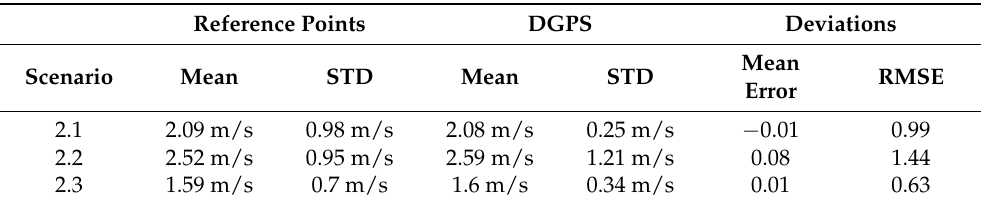
Table 6. Comparison of forward speed between Reference Points approach and DGPS measurements using berthing scenarios (Scenarios 2.1–2.3).